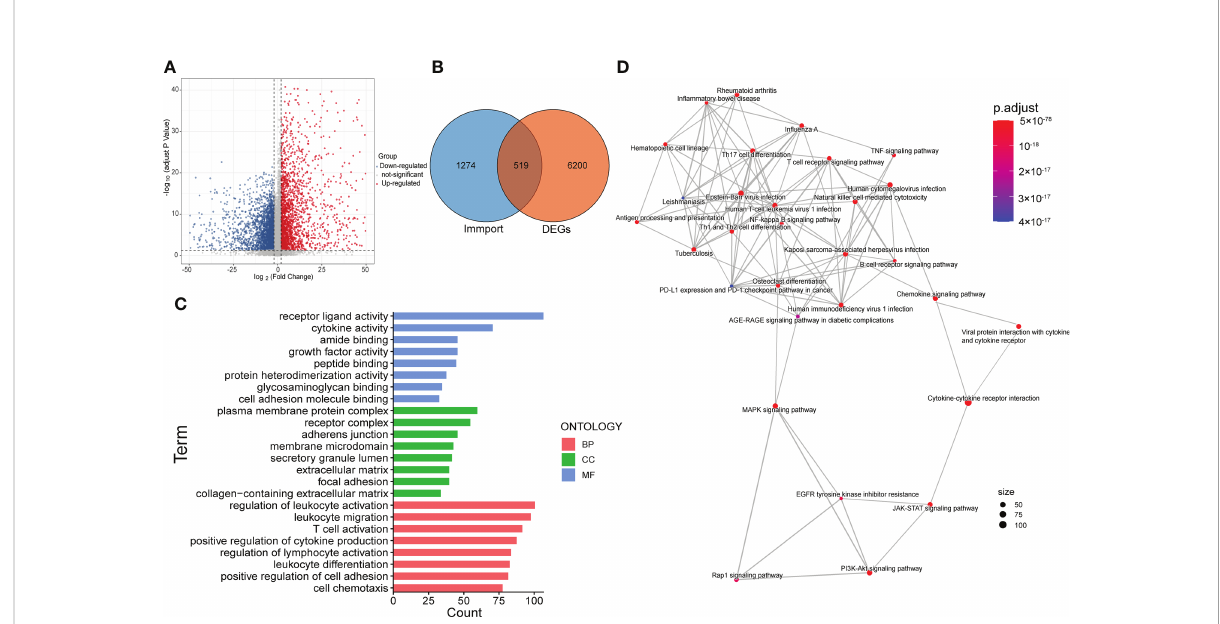
FIGURE 3 Screening and functional enrichment analysis of immune-related DEGs. (A) Volcano map showed the DEGs between cluster 3 and cluster 1. (B) Venn diagram displayed the amount of immune-related DEGs. (C) Top 8 items of molecular function (MF), cellular component (CC) and biological process (BP) of GO analysis. (D) The result of KEGG pathway